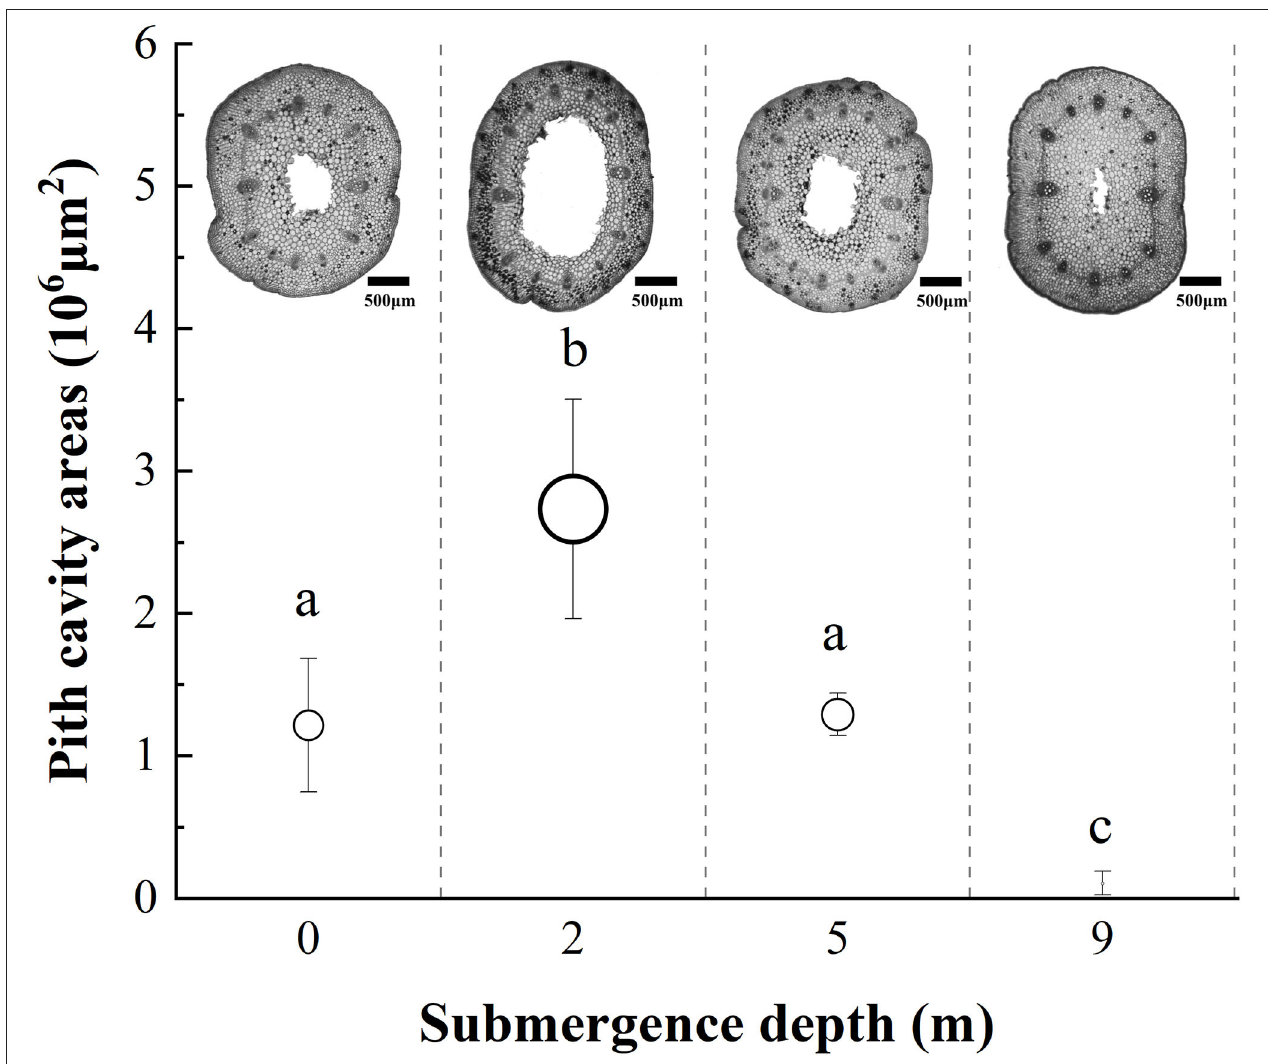
FIGURE 3 | The pith cavity transverse areas of immature internodes of A. philoxeroides at the end of treatment at different submergence depths (mean ± S.E; n = 3). Sections were made at the middle position of internodes. Different lower-case letters indicate significant differences ( p < 0.05 using one-way ANOVA) between